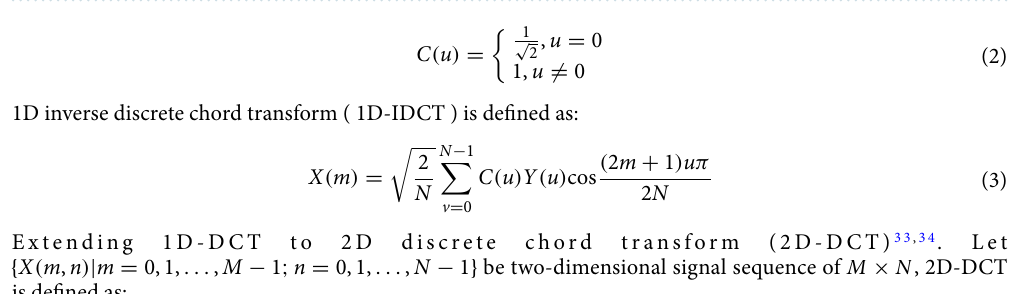
Figure 1. Differential comparison of DCT restoration results under different